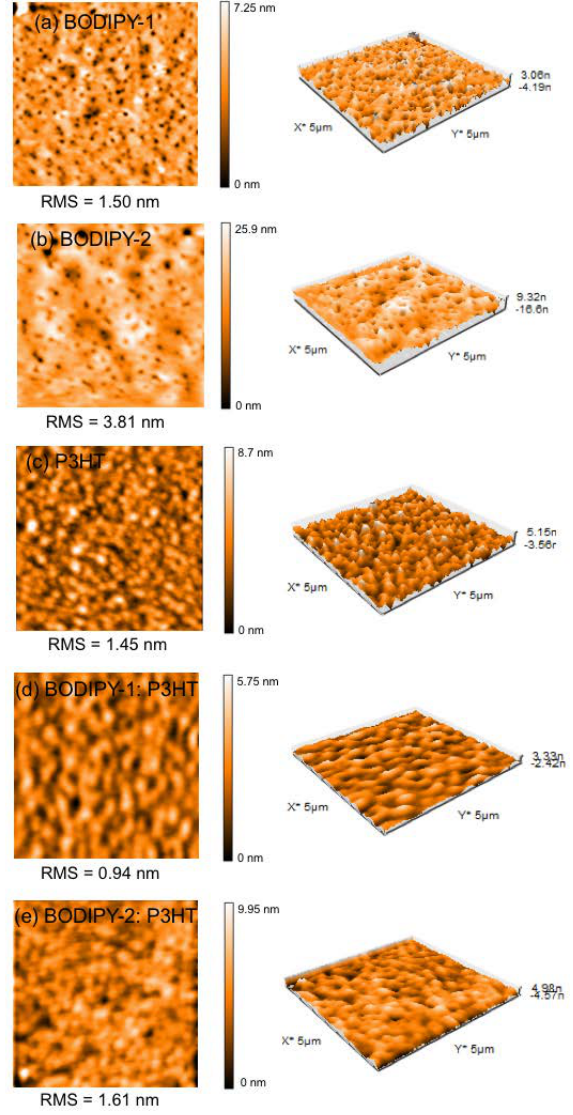
Figure 6. Tapping-mode atomic force microscope (AFM) images (5 µm × 5 µm): ( a ) BODIPY-1 :PCBM